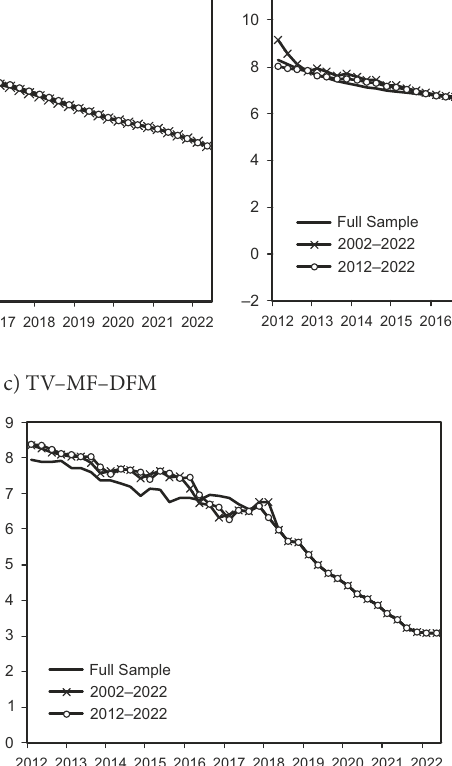
Figure 3. Estimated trends in different sample